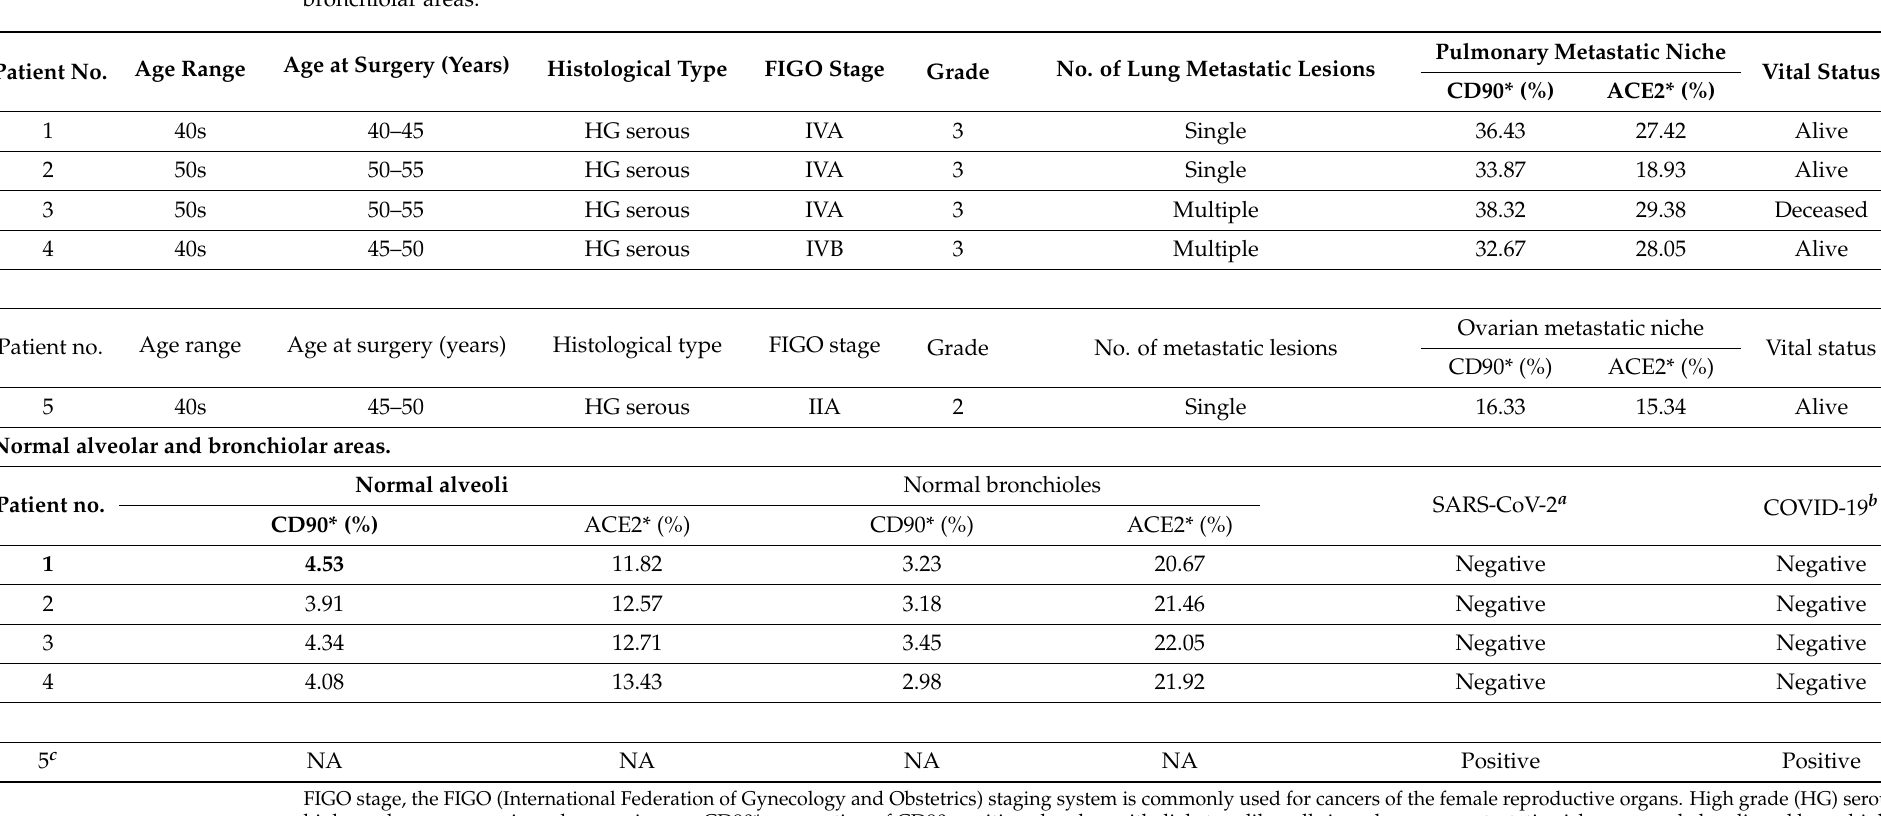
Table 1. Characteristics of patients with ovarian cancer and lung metastases as well as CD90 and ACE2 expression in the metastasis areas and the alveolar and bronchiolar